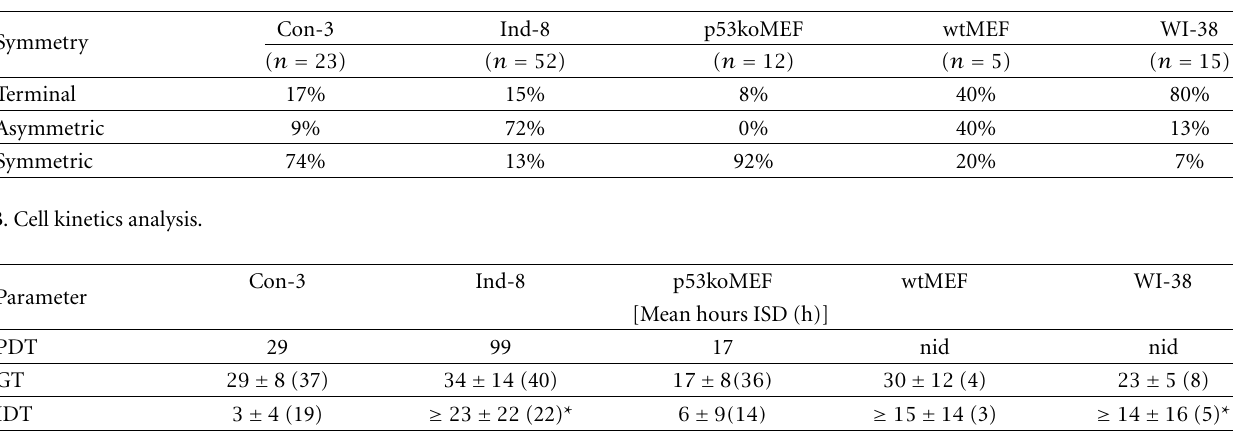
Table 1: Division symmetry analyses of p53-expressing and p53-null fibroblasts. A. Division symmetry